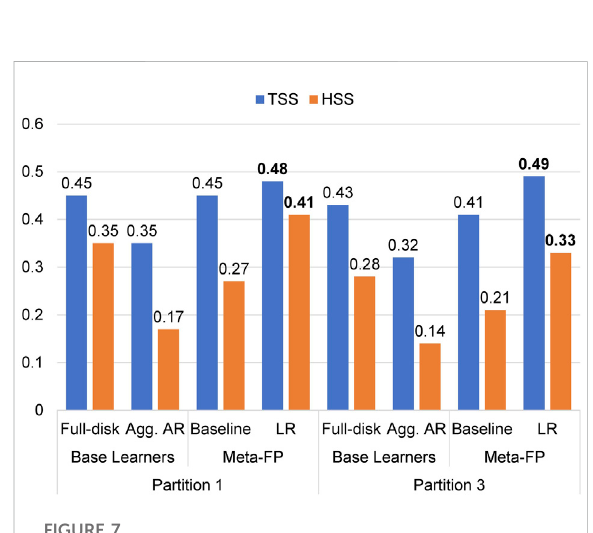
FIGURE 7 Validation Scores of base learners in Fold-3 (base learners trained with Partitions 2 and 4) and the corresponding validation scores of Meta-FP (meta models trained in Expt.